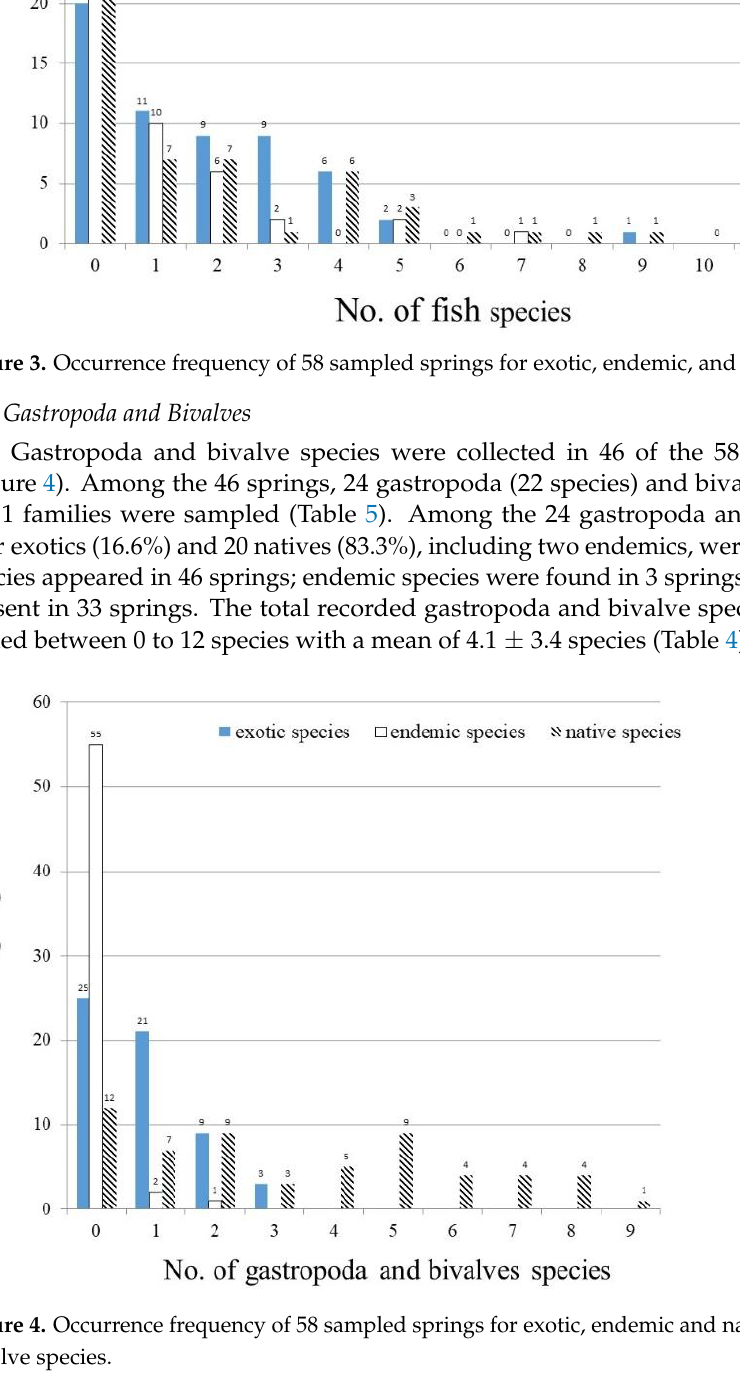
Figure 4. Occurrence frequency of 58 sampled springs for exotic, endemic and native gastropoda and bivalve species. Table 5. The occurrence and frequency of recorded gastropods and bivalves in the 58 sampled springs of Taiwan (Ethnic groups: Exotic species (EX)/Native species (NA)/Endemic species (NA*)).